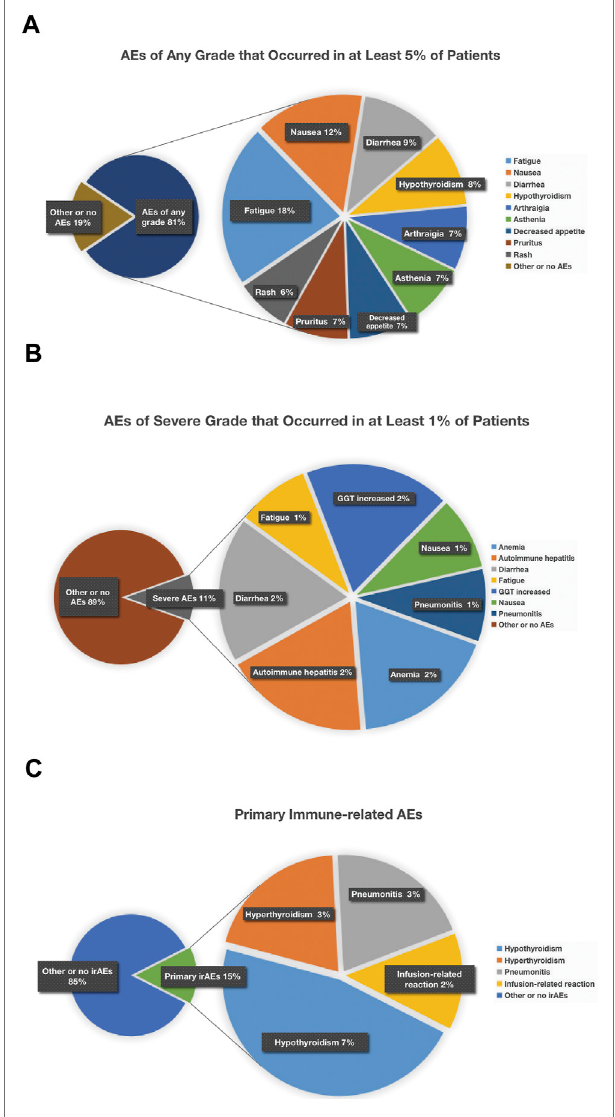
FIGURE 9| Treatment-related AEs ofany grade that occurred in at least 5% of patients (A) , treatment-related AEs of severe grade that occurred in at least 1% of patients (B) , and chematic fi gure concerning primary immune- related AEs (C) . Treatment-related AEs of any grade that occurred in at least 5% of patients were fatigue (18%), nausea (12%), diarrhea (9%), hypothyroidism (8%), arthralgia (7%), asthenia (7%), decreased appetite (7%), pruritus (7%), and rash (6%) (A) ; treatment-related AEs of severe grade that occurred in at least 1% of patients were anemia (2%), autoimmune hepatitis (2%), diarrhea (2%), fatigue (1%), GGT increased (2%), nausea (1%), and pneumonitis (1%) (B) ; as for irAEs, manifesting as hypothyroidism (7%) was most common, and hyperthyroidism (3%), pneumonitis (3%), and infusion- related reaction (2%) were relatively less common (C)